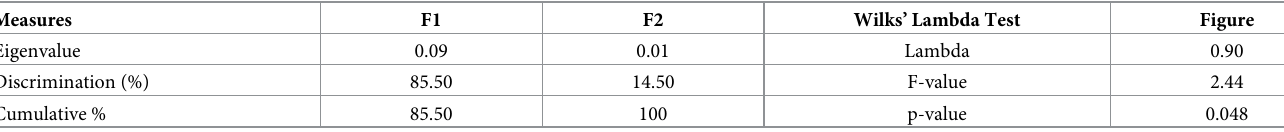
Table 9. Discriminant factors of interpersonal trust and the simultaneous test. Measures F1 F2 Wilks’ Lambda Test Figure Eigenvalue